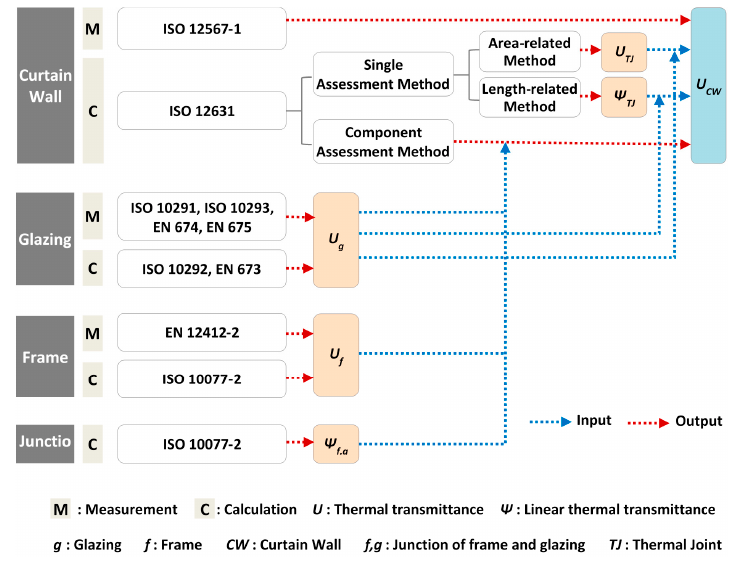
Figure 1. Determining process of U CW by measurement and calculation.